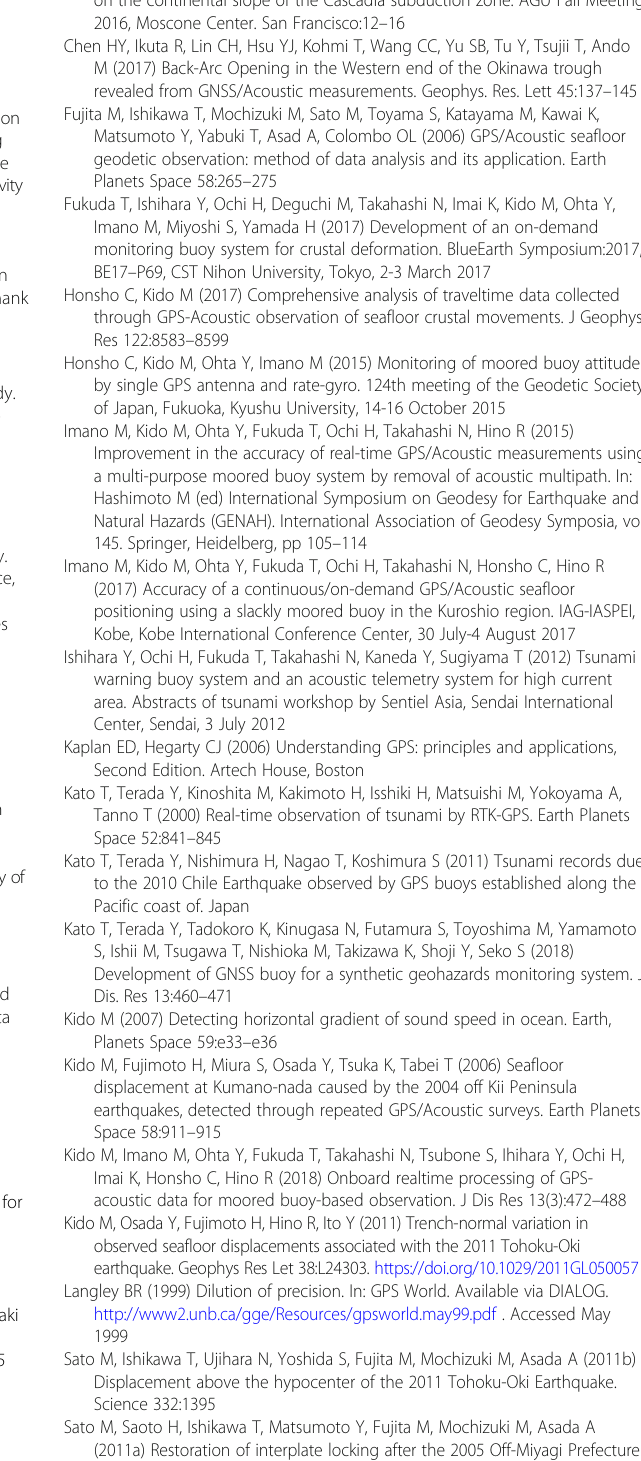
Fig. S6. Black indicates a DOP value greater than 5. Figure S8. Map views of components of Equation (8). (a) D xx , (b) D yy , and (c) D xy . The gray circle indicates a radius of 4 km from the array center. (DOCX 2155